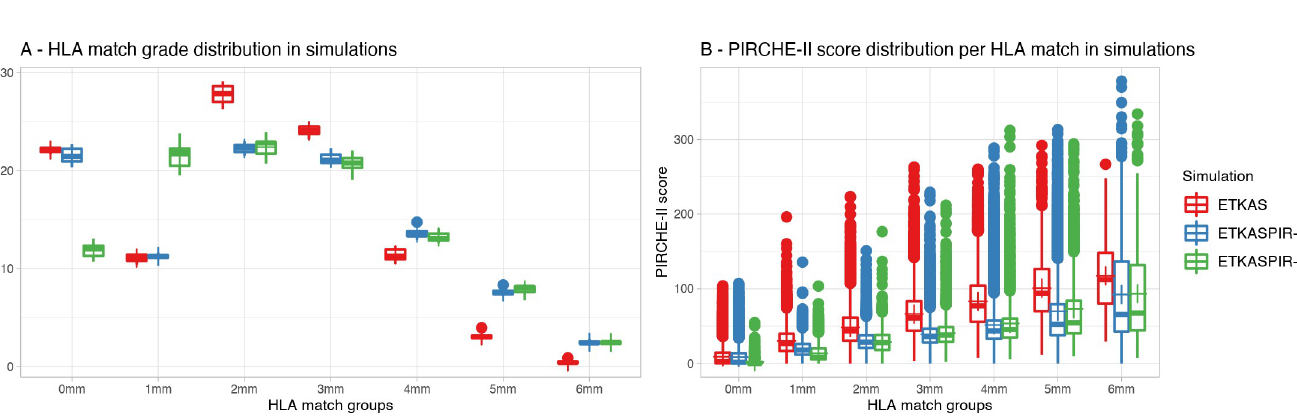
Fig 8. Impact on match grade. (A) In ETKASPIR-F (green), the proportion of simulated transplants with a full HLA match reduces when compared to ETKAS (red). ETKASPIR-E (blue) compensates for that by maintaining the current ETKAS priority for HLA full matches. (B) PIRCHE-II scores are reduced in every HLA match group. Boxplots depict the median (horizontal line), mean (plus) and first to third quartile (box), the highest and lowest value within 1.5x IQR (whiskers), outliers